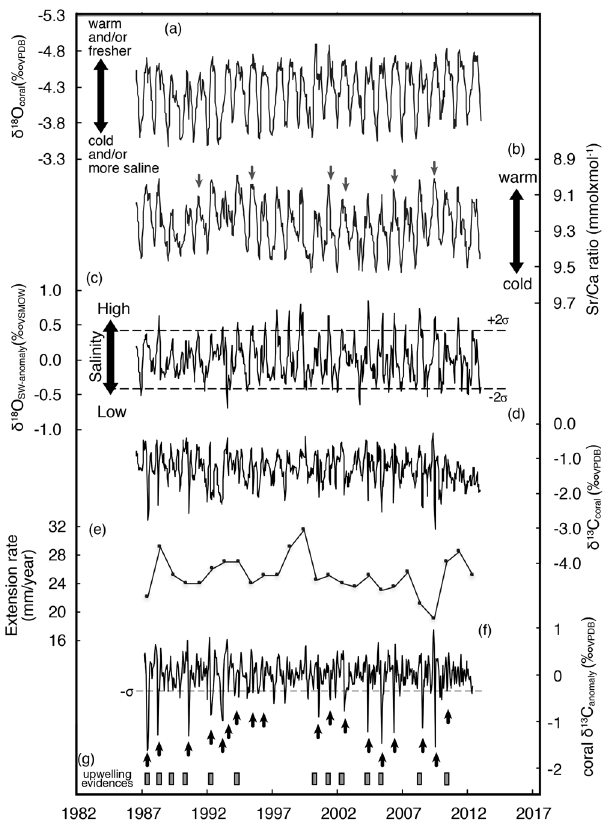
Figure 1. Oman coral proxy records and extension rate. ( a ) Coral skeletal δ 18 O VPDB record, ( b ) Coral skeletal Sr/ Ca ratio record. Grey arrows indicate the years of non-increasing Sr/Ca ratios in summer. ( c ) δ 18 O SW-anomaly , ( d ) Coral skeletal δ 13 C VPDB record, ( e ) Extension rate calculated from distances between the anchor points in winter of each year. ( f ) Oman coral skeletal δ 13 C VPDB anomaly. The timing of anomalous negative excursions of AN- δ 13 C in the summer are shown as black arrows. ( g ) In situ data showing low-SST and high chlorophyll-a (square